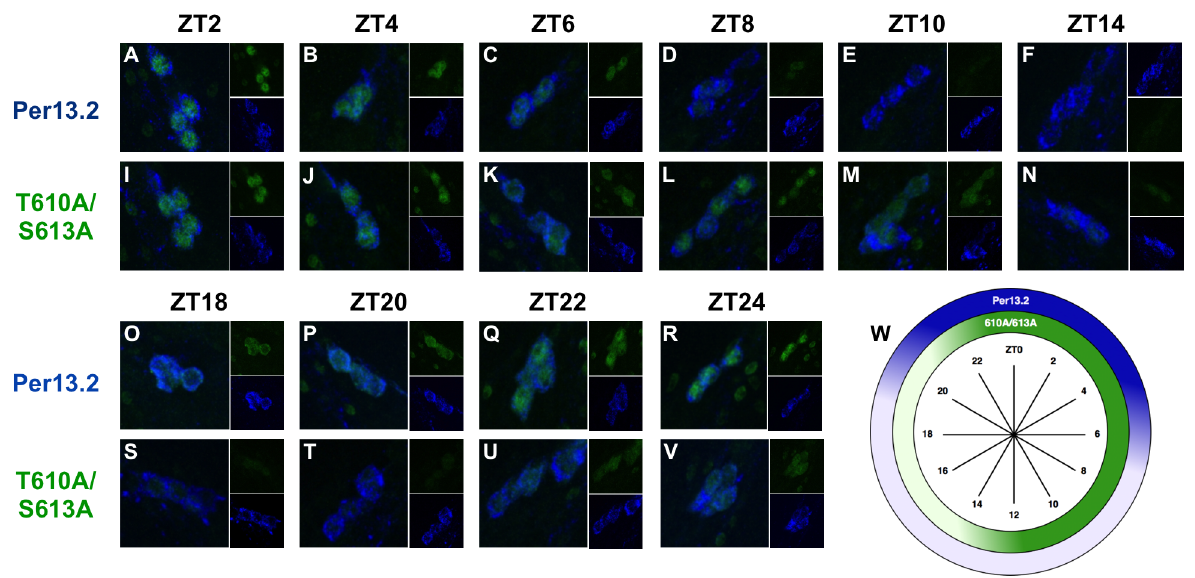
Figure 6. PER-T610A/S613A displays prolonged expression in the small LN v s. Brains from male per 01 flies expressing the indicated transgene were stained with anti-PER (green; UP1140) and anti-PDF (blue; HH74). Small ventral lateral neurons (LN v s) are shown in each panel. ZT time points are indicated at the top of each set of panels. ( A–F, O–R ) Wild type PER ( per 13.2) accumulates in the nucleus of small LN v s starting at approximately ZT22, is highly expressed and nuclear by ZT0, and is largely absent by ZT8. ( I–N, S–V ) PER-T610A/S613A exhibits prolonged expression during the day, ZT2-14, and is turned-over at , ZT14, much later than wild type PER. Additionally, the double mutant protein appears to accumulate slightly slower than wild type (compare time points at ZT22 and ZT24) ( W ) Diagram depicting the highest levels of PER-13.2 (dark blue) and PER- T610A/S613A (dark green) throughout the day.